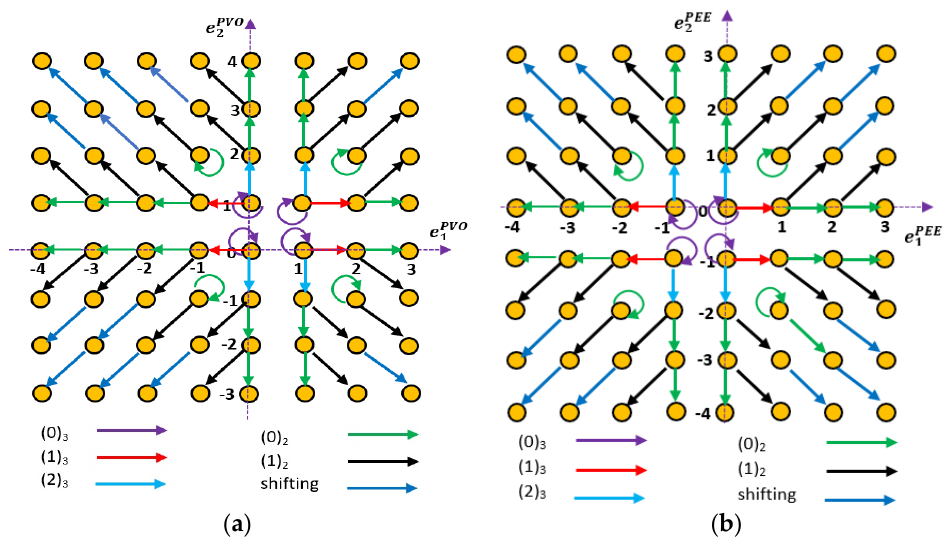
Figure 2. Prediction error pair modification/mapping. ( a ) Error pair expansion for EP-IPVO strategy. ( b ) Error pair expansion for EP-PEE strategy.